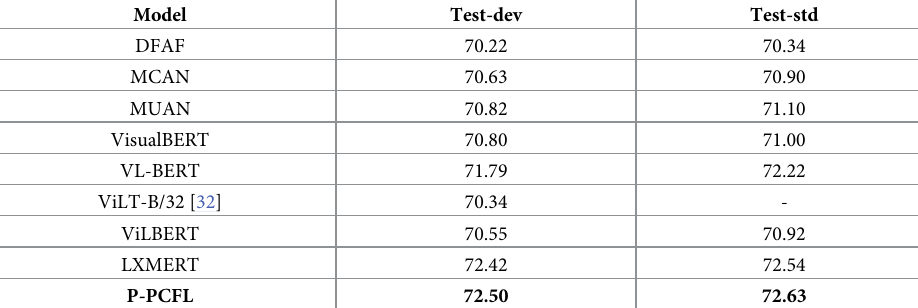
Table 4. Comparison of P-PCFL model and other models on VQA